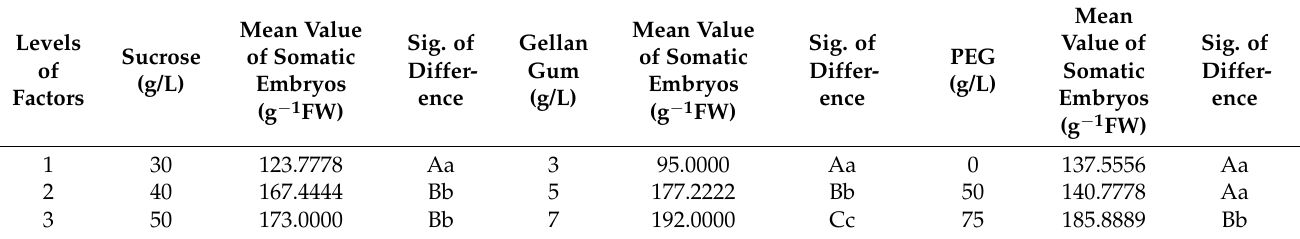
Table 3. Multiple comparison of effect of sucrose, phytagel and PEG on somatic embryo maturation.